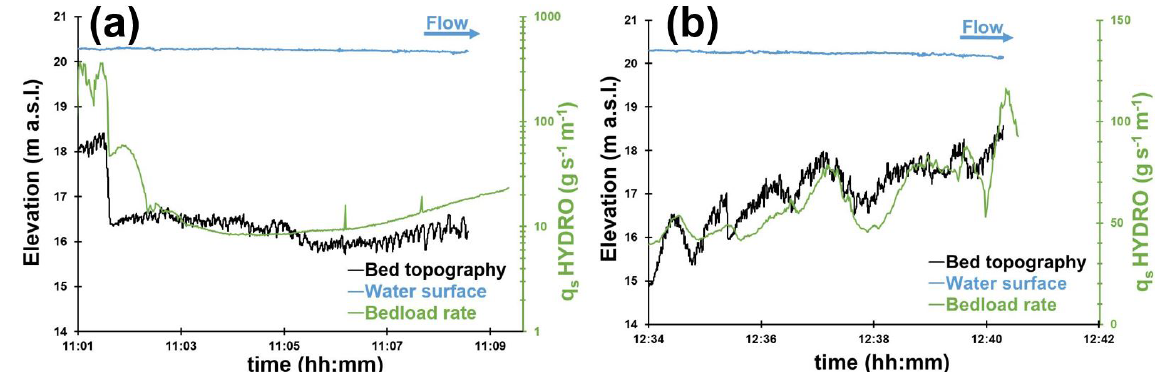
Figure 11. Bedload rates calculated on bedforms using the hydrophone and Eq. (16) near a bar front (a) and on a dune field (b) . Bed topography and water surface along two longitudinal bathymetric profiles for the 8 February 2018 survey, Q = 1550m 3 s − 1 : (a) P10, mean water depth = 3.8m. The profile length from 11:01 to 11:09LT corresponds to 400m; (b) P12, mean water depth = 3.4m. The profile length from 12:34 to 12:41LT corresponds to